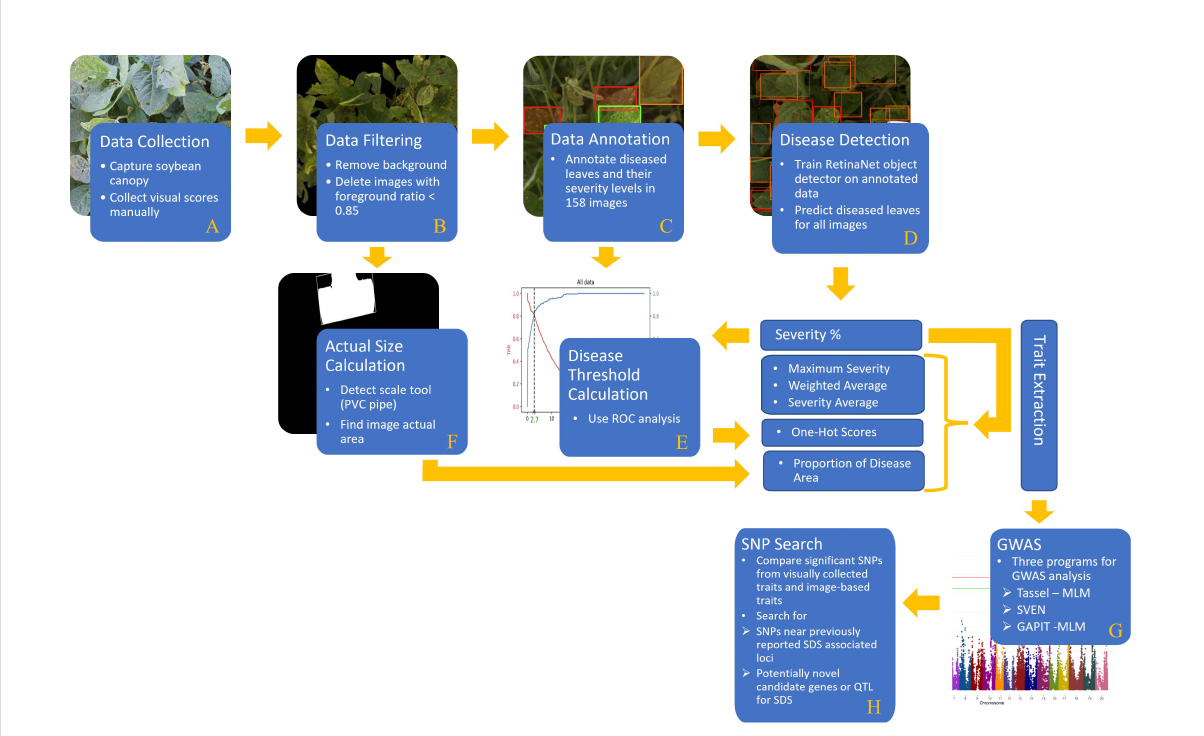
FIGURE 1 A comprehensive fl owchart of the steps of our proposed method: (A) data collection, (B) data fi ltering, (C) data annotation, (D) disease detection, (E) disease threshold calculation, (F) actual size calculation, (G) GWAS, and (H) SNP